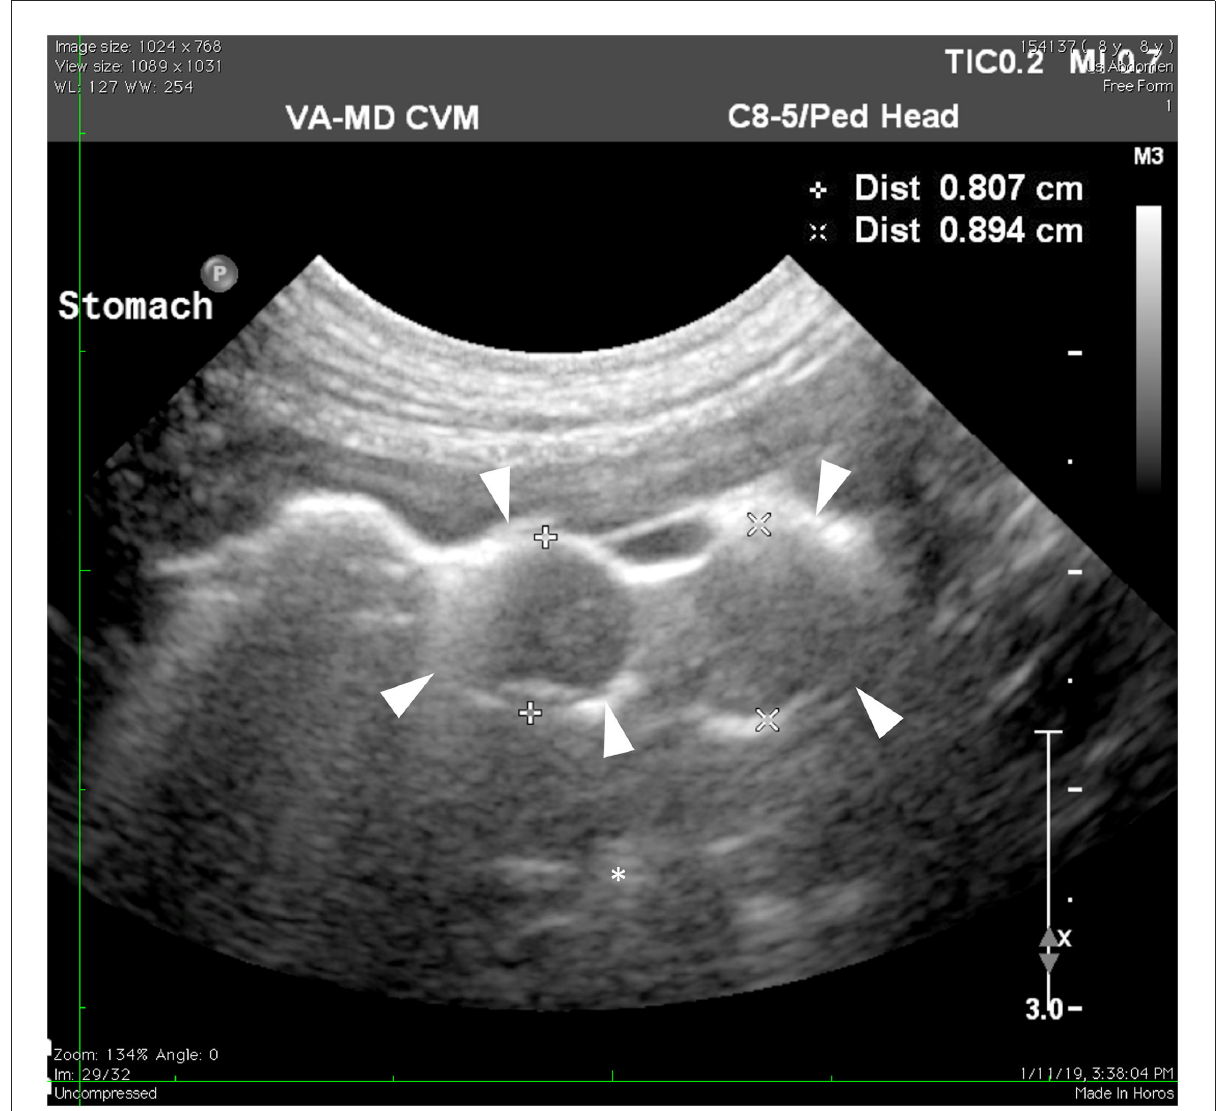
FIGURE1 Ultrasonography of the stomach. The hypoechoic masses (arrowheads) protruding toward the lumen of the stomach are less echogenic than stomach contents